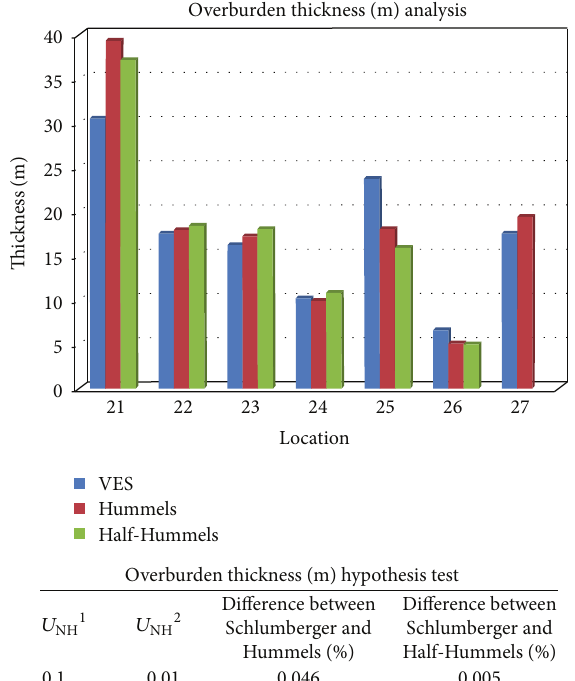
Figure 19: Bar chart and statistical test of hypothesis table for the different array methods comparing overburden thickness for locations on augen